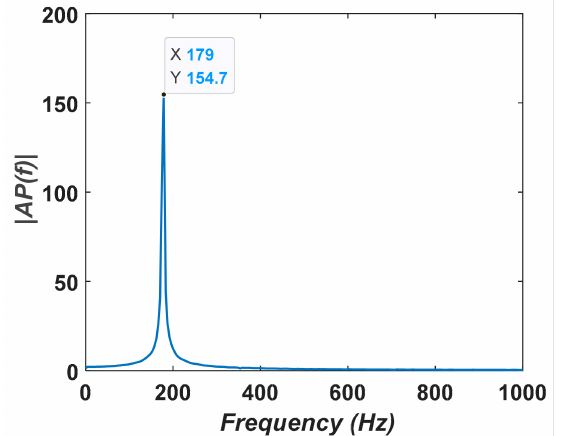
Figure 10. Fast Fourier transform (FFT) plot of the gauge pressure. To compare the simulated oscillating mode with the prediction, the dynamic pressure along the centerline at time 1.400445 s was normalized by the maximum pressure ampli- tude, meanwhile the velocity along the center line at time 1.40585 s was normalized by the maximum velocity amplitude. In Figure 11, the normalized pressure and axial velocity of this work are compared with the analytical second acoustic pressure mode and veloc- ity mode, and the normalized pressure and axial velocity in reference [23]. The simulation pressure distribution along the centerline is in good agreement with the analytical